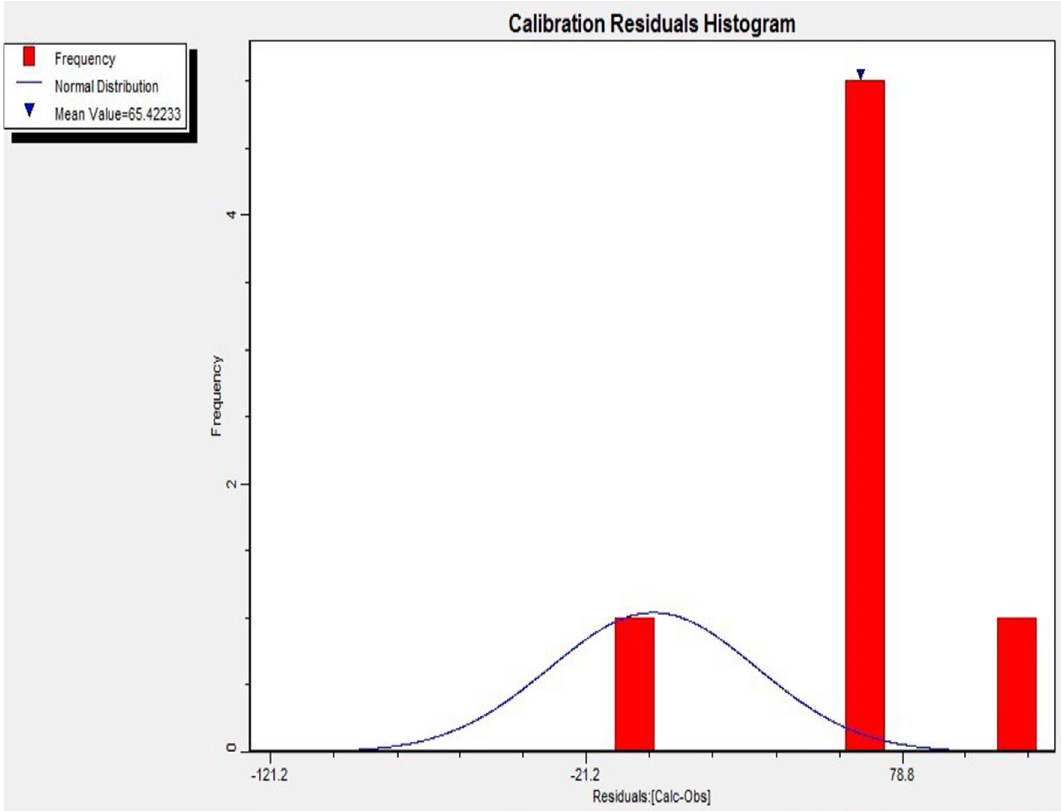
Fig. 12 Calculated vs. observed head using steady-state